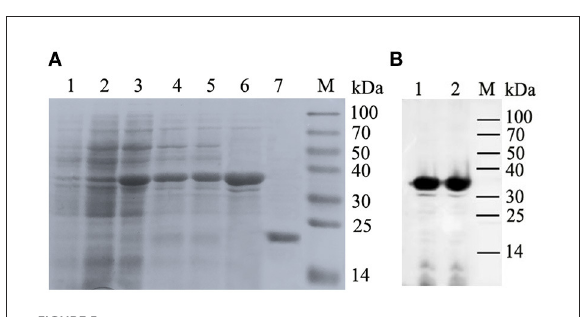
FIGURE5 Co-expression of pET28-small ubiquitin-like modifier (SUMO)-IFN- ε and Tf16 chaperone plasmid, protein purification and Western blotting. (A) Expression of (SUMO)-IFN- ε and Tf16 chaperone plasmid and protein purification. Lanes: 1, Recombinant strain containing pET28a-SUMO-MiIFN- ε and Tf16 chaperone protein plasmid cultured; 2, cultured and induced for 48h using L-arabinose; 3, Induced with isopropyl β -d-thiogalactoside for 48h at 16 ◦ C; 4, cell lysate supernatant; 5, centrifugal precipitation after cell lysis; 6, Elution buffer; 7, the purified SUMO-IFN- ε was digested using a SUMO protease to remove the SUMO label; M, protein molecular weight standard. (B) Western blot analysis of His-tag recombinant SUMO-MiIFN- ε by 6-poly histidine monoclonal antibodies. 1 and 2. SUMO-MiIFN- ε ;M, protein molecular weight